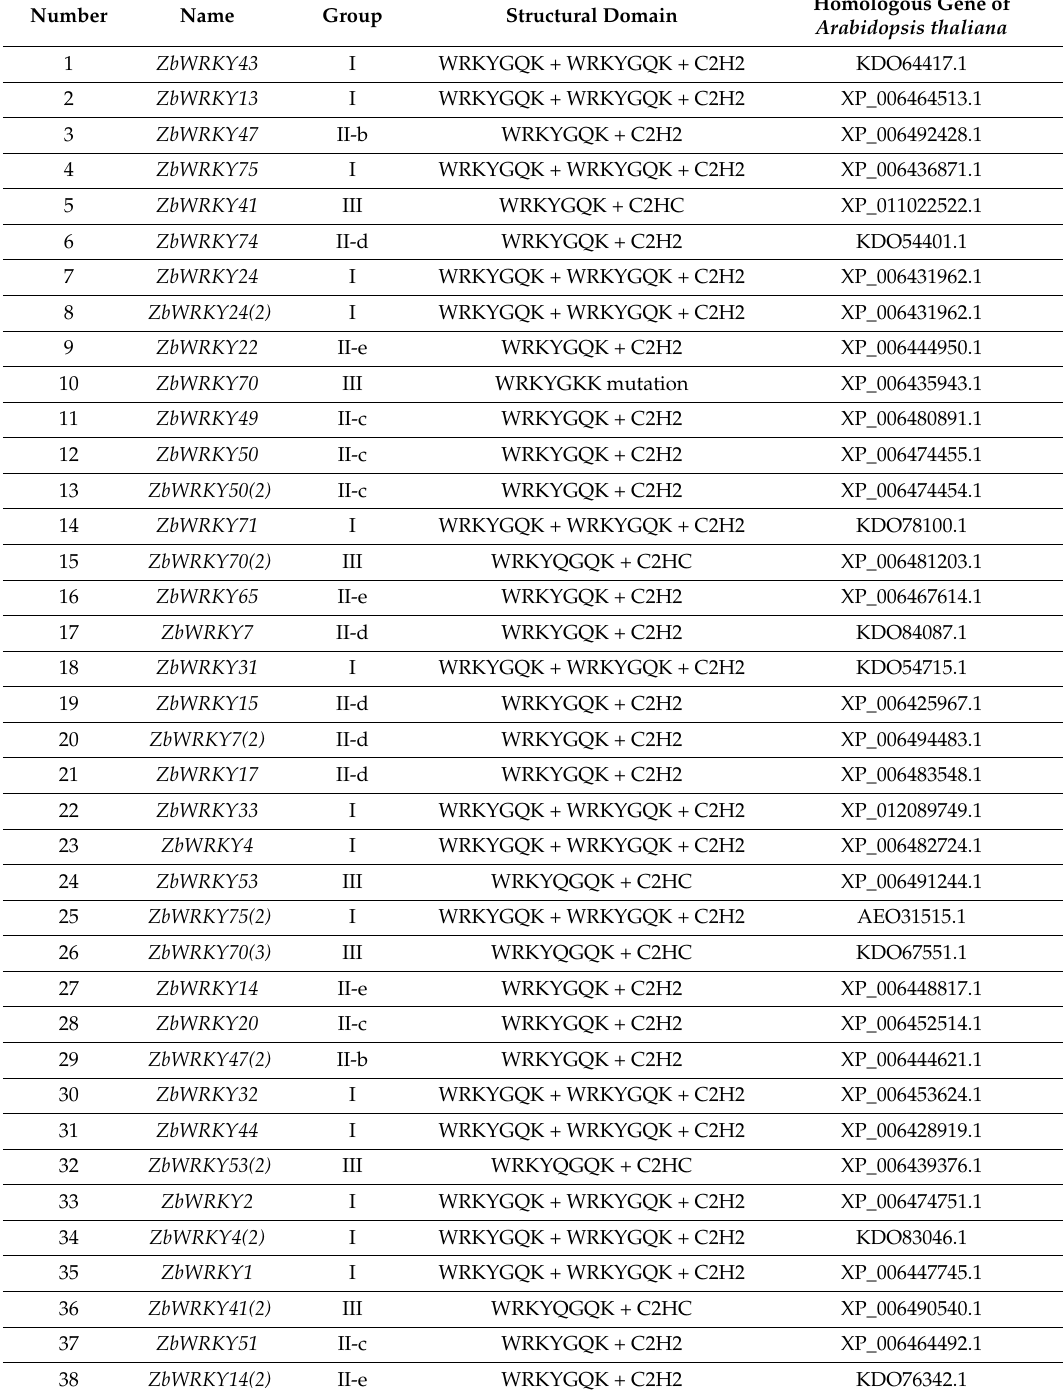
Table 1. Zanthoxylum bungeanum WRKY protein sequence classification and